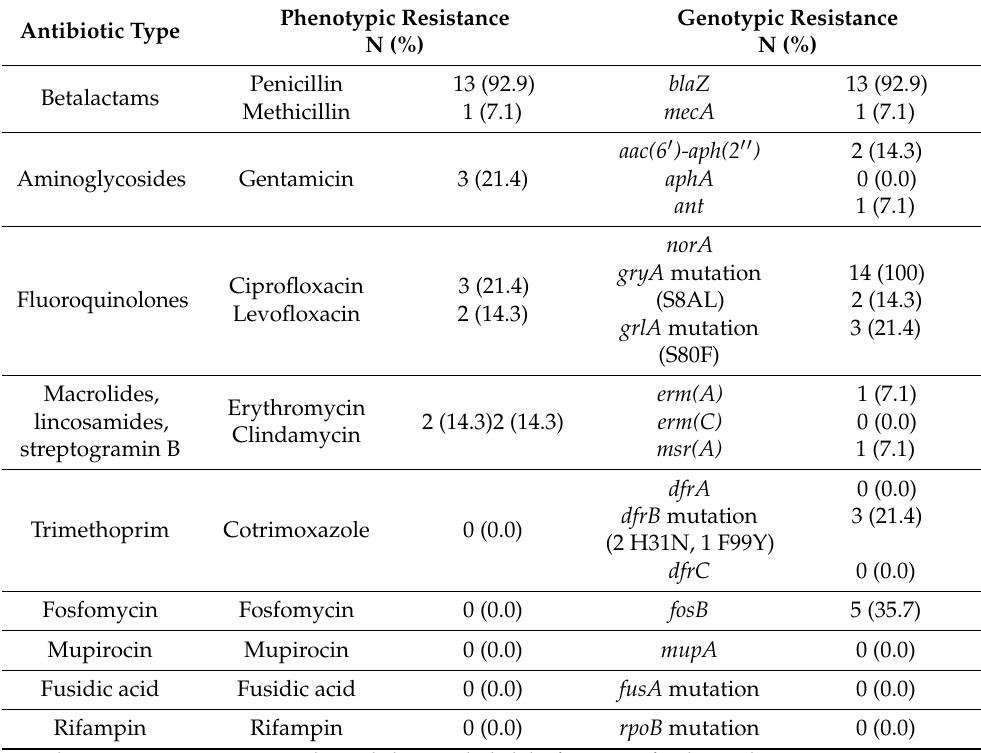
Table 2. Correlation of phenotypic and genotypic antimicrobial resistance of 14 PJI isolates a . Antibiotic